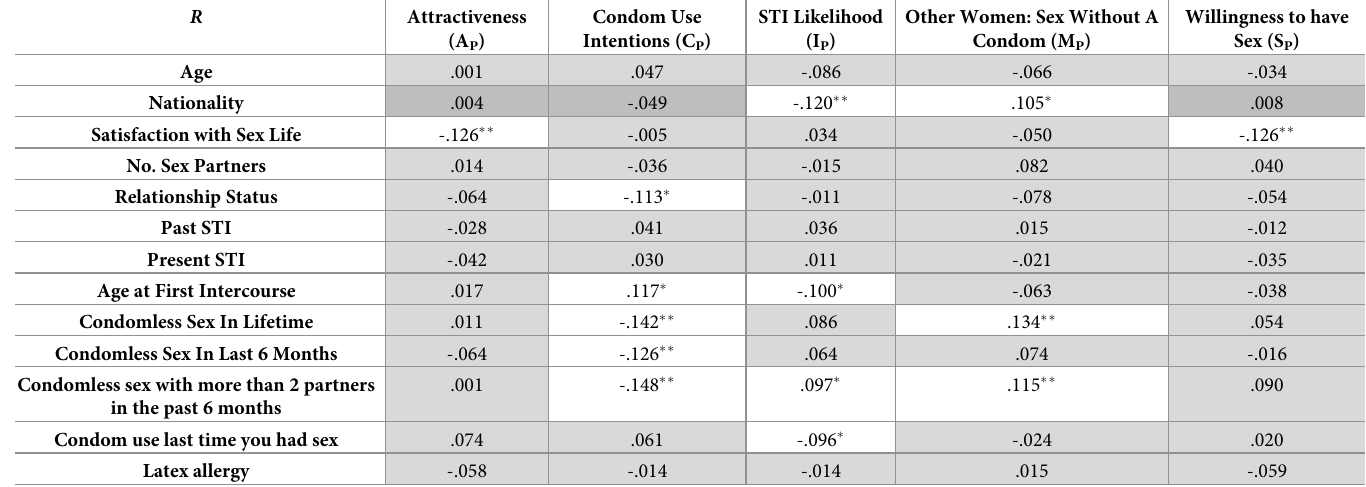
Table 4. Bivariate associations (Pearson’s r ) between 480 (df = 478) participant demographic and sex experience variables (left column) and their mean ratings of 20 men. Significance levels are indicated: � = p < 0.05, �� = p < 0.01, grey cells =